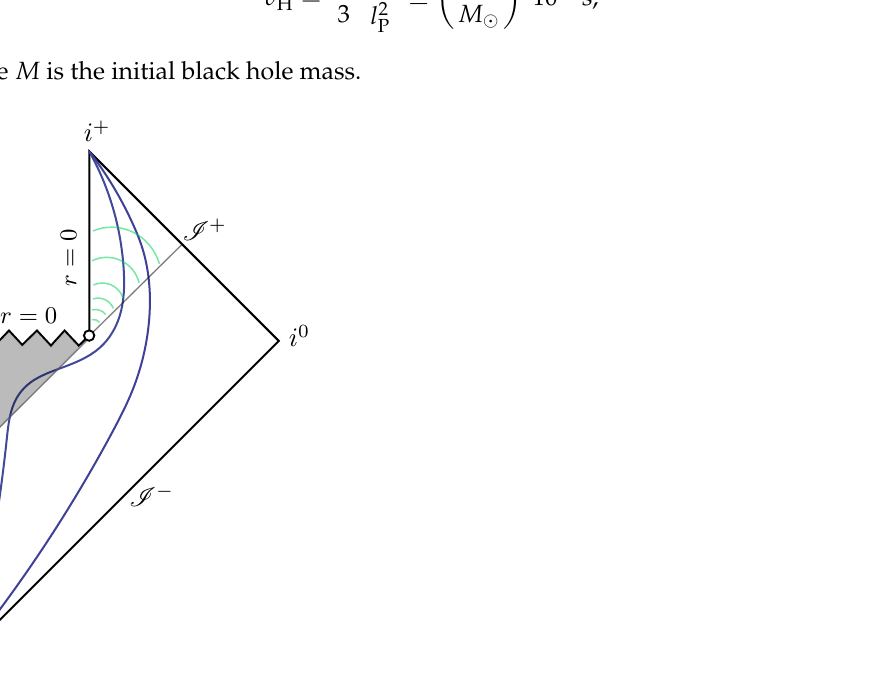
Figure 3. Causal diagram of a Hawking-like evaporating black hole. The shaded portion corresponds to the interior of the event horizon, which exists up to the end point of the evaporation process. The blue curves joining i − and i + qualitatively represent r = const. surfaces. The green wave fronts represent the causal effect of the thunderbolt on future